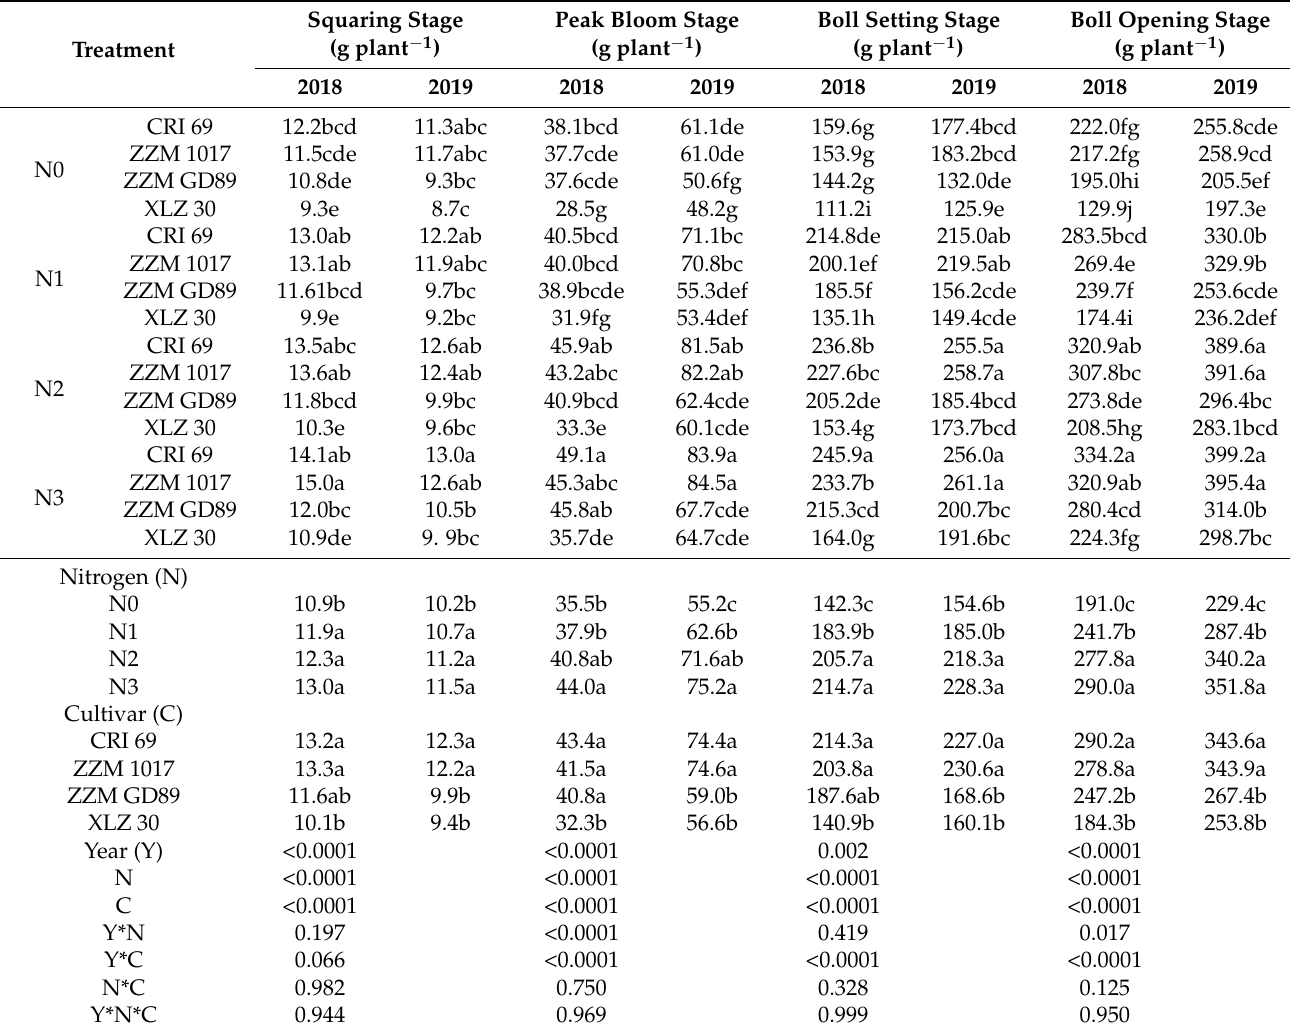
Table 2. Biomass accumulation of cotton cultivars under different N-supply conditions in 2018 and 2019